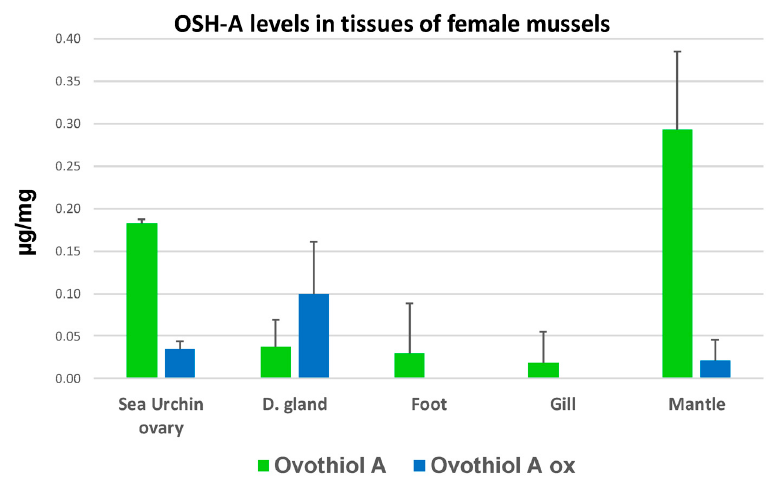
Figure 7. Ovothiol A concentrations in tissues of female mussels. Graph shows the concentrations of reduced and oxidized OSH-A in tissues of mussels captured in Plentzia at stage 4 of oogenesis. Concentrations in mature P. lividus ovary are also shown for comparative